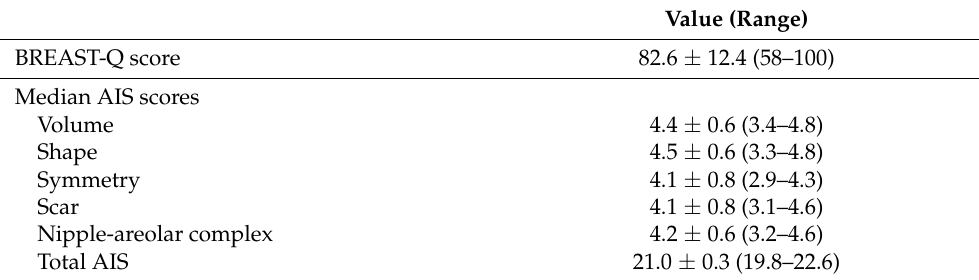
Figure 4. Pre- ( A ) and postoperative ( B ) 12-month photographs. This 54-year-old patient was diagnosed with invasive breast cancer of the left breast; the resected breast tissue weighed 243 g. A 170-cc breast implant and 16 × 16 cm 2 Megaderm ® ADM were placed inside. The red dotted line indicates the upper border of the breast. The area to be anchored to the ADM is marked. ADM, acellular dermal matrix. Table 3. Satisfactory outcomes using the BREAST-Q and